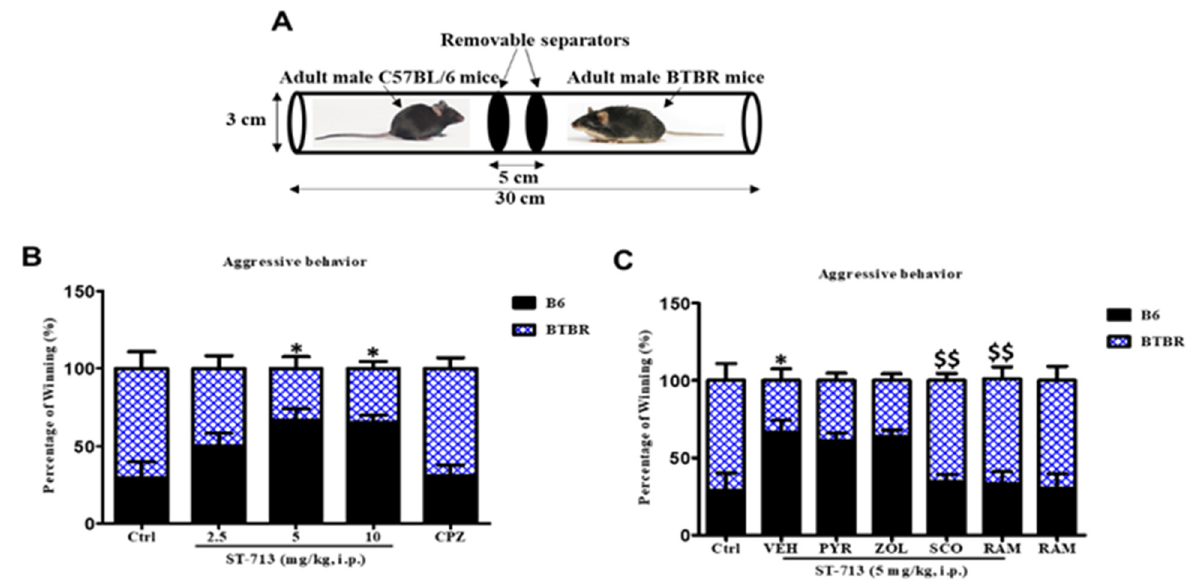
Figure 2. ST-713 reduced aggressive behavior of BTBR mice in a behavioral tube test. Experimental setup for the conducted test tube to assess aggression ( A ). The results obtained were percentage winning ( B ), and the results observed for abrogative properties of pyrilamine, zolantidine, scopolamine, or ( R )- α -methylhistamine on the enhancements obtained with ST-713 on aggressive behaviors of autistic-like mice ( C ). Figures show mean ± SEM (n = 6). * p < 0.05 vs. VEH-treated BTBR group. $$ p < 0.01 vs. ST-713-(5 mg)-treated BTBR group.